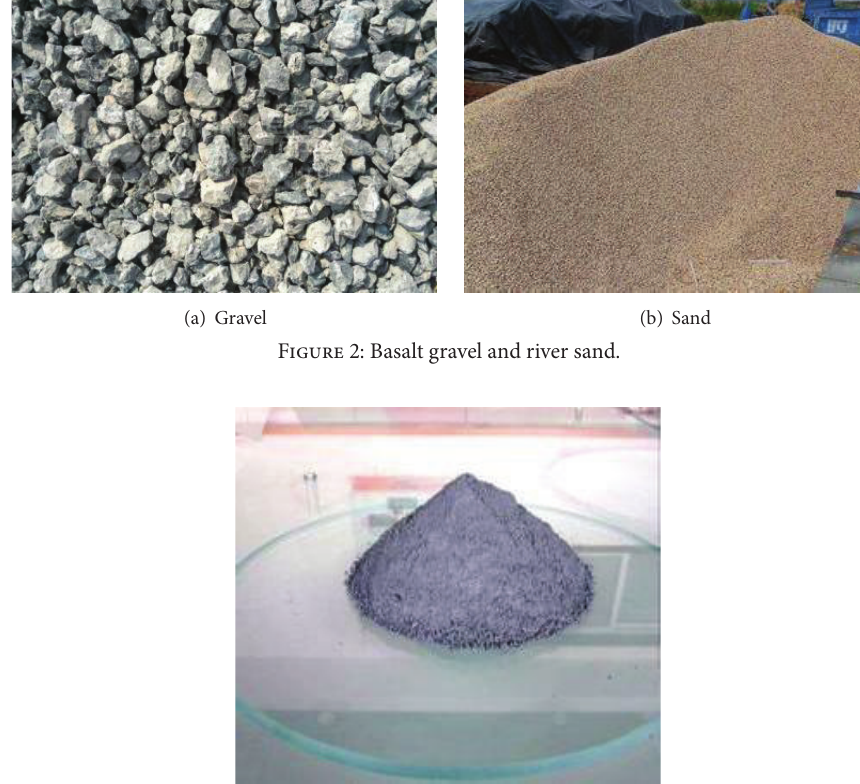
Figure 3: Cement powder.